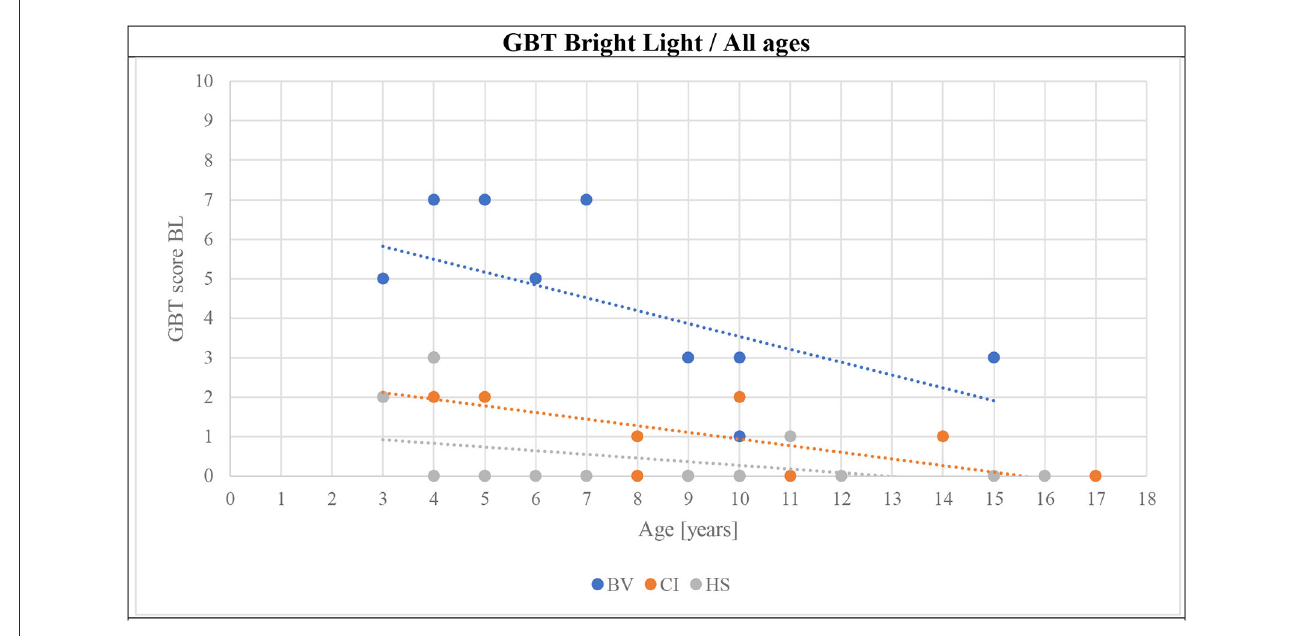
FIGURE6 Evolution of the GBT scores of all subjects in BL conditions as a function of age (BV, blue symbols; CI, orange symbols; HS, gray symbols).